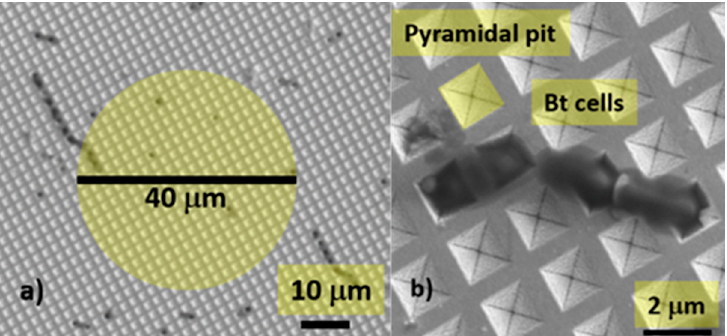
Figure 1. ( a ) Scanning Electron Microscope (SEM) image of a Bt -contaminated surface-enhanced Raman spectroscopy (SERS) substrate. The yellow circle shows the dimension of the laser spot and, consequently, the scanned area ( b ) some Bt cells deposited on the substrate, a pyramidal pit is highlighted in yellow.